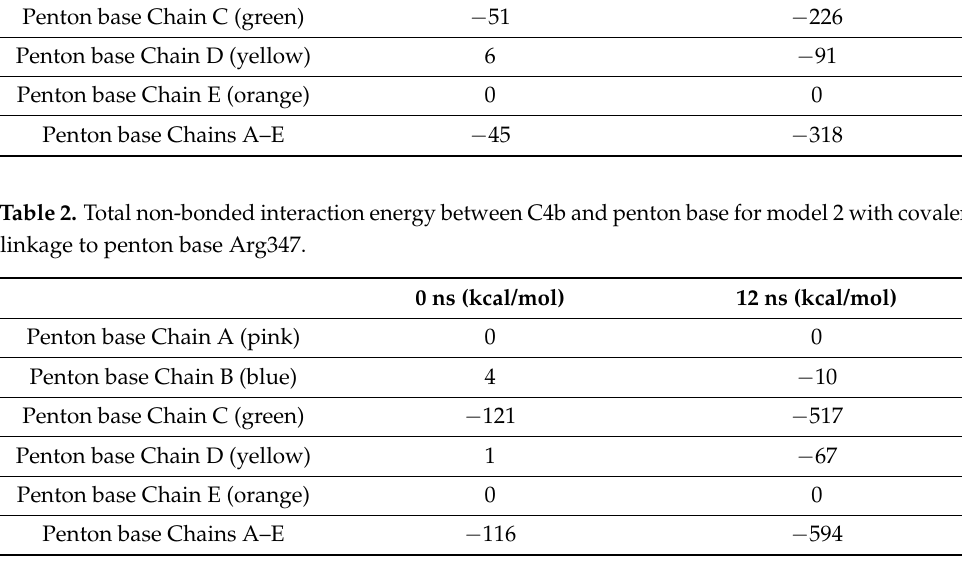
Table 1. Total non-bonded interaction energy between C4b and penton base for model 1 with covalent linkage to penton base Thr343. 0 ns (kcal/mol) 12 ns (kcal/mol) Penton base Chain A (pink) 0 0 Penton base Chain B (blue) 0 Penton base Chain C (green)